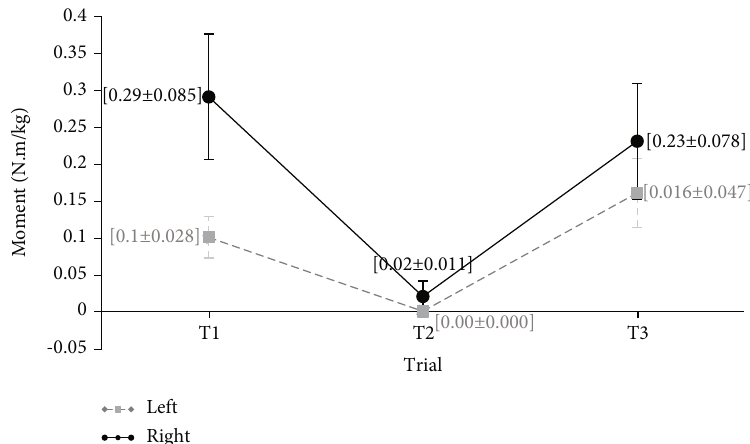
Figure 7: Mean values of fl exion-extension of the elbows moments in three distances of the keyboard (Nm/kg).